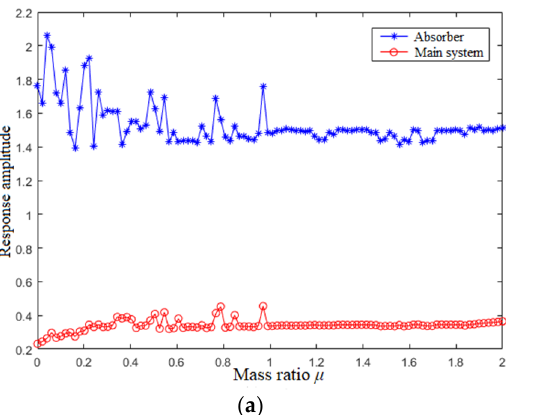
Figure 12. Response amplitude and phase diagram of two vibrators in the case of off-resonance ω =0.6. ( a ) Response amplitude; ( b ) Phase diagram ( μ = 0.2).